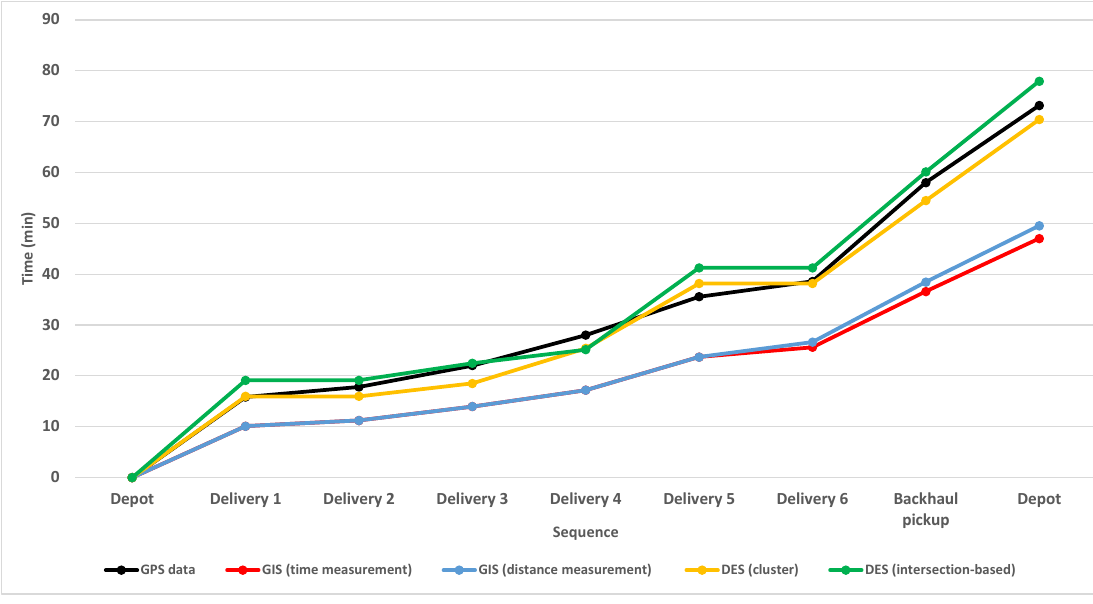
Figure 9. Travel distance for consignments from GPS data and DES results.